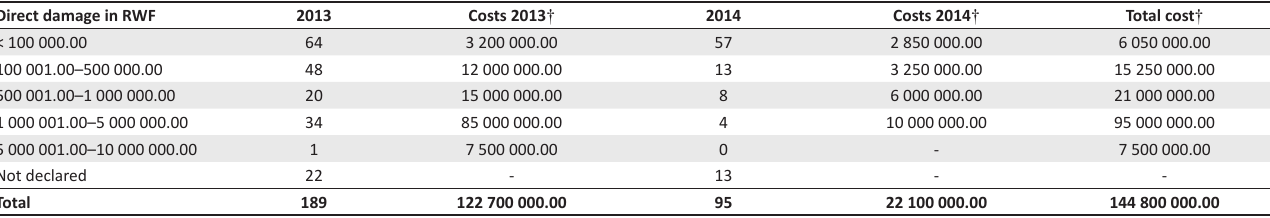
TABLE 4: Estimation of direct (physical) damage costs based on the most severe event for each enterprise by year cross-analysed with estimated direct damage costs for those events (all amounts in Rwandan franc). Direct damage in RWF